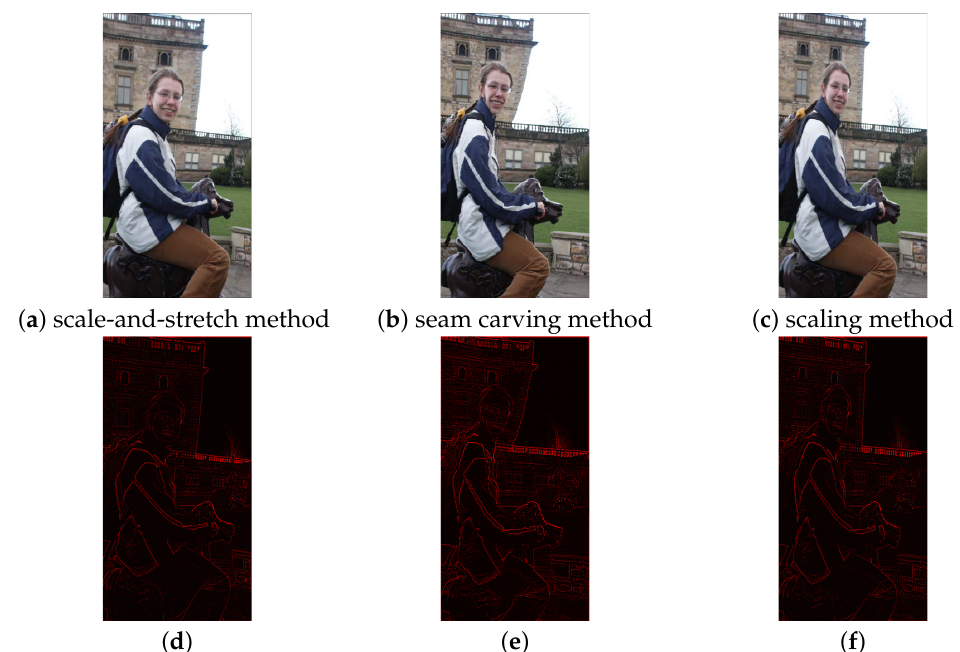
Figure 4. Tampered images and correspond residual images obtained by different re-targeting methods: ( d – f ) corresponds to the residual LTM diagram of ( a – c ), respectively.